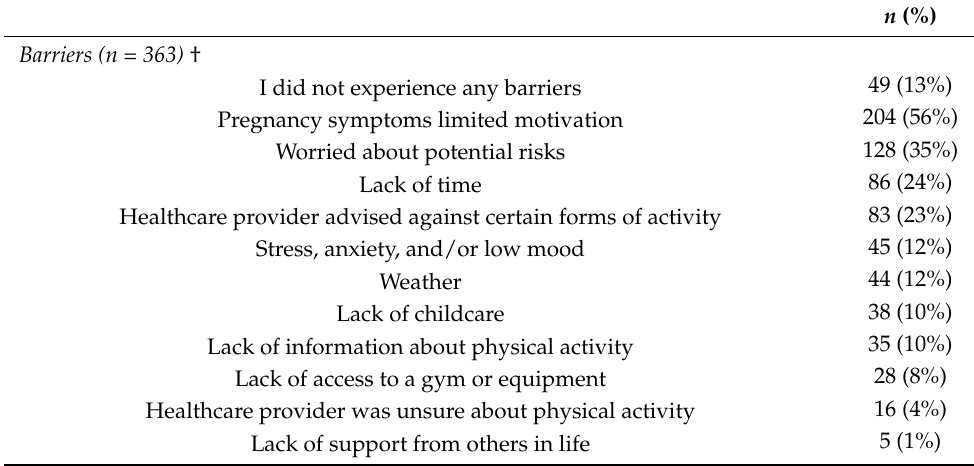
Table 3. Barriers and physical symptoms to physical activity in multifetal